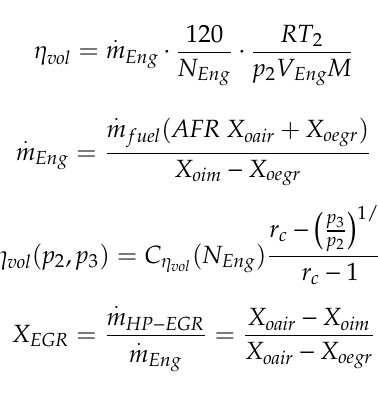
Figure 7. Comparison of three performance variables with NOx concentration.